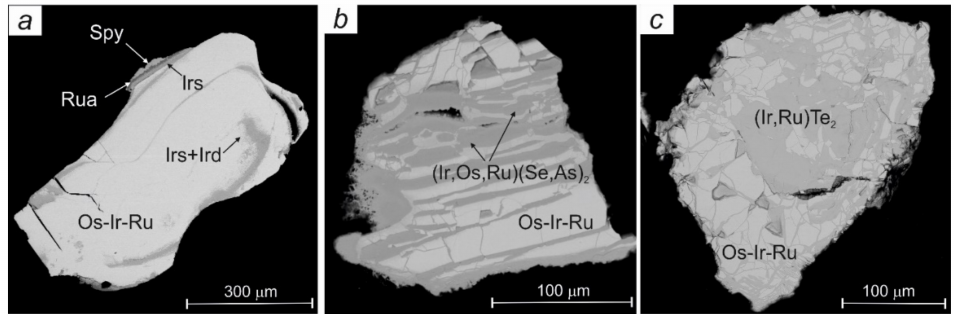
Figure 5. BSE images showing secondary textures metasomatic alteration of Os-Ir-Ru alloys: ( a ) micro- zonal texture with zones composed of sulfoarsenides (irarsite (Irs), ruarsite (Rua)) and arsenides (iridarsenite (Ird), sperrylite (Spy), ( b ) micro-striped texture with zones formed by arsenoselenides, ( c ) micro-breccia texture in a deformed primary Os-Ir-Ru grain are cemented by tellurides of the PGE.